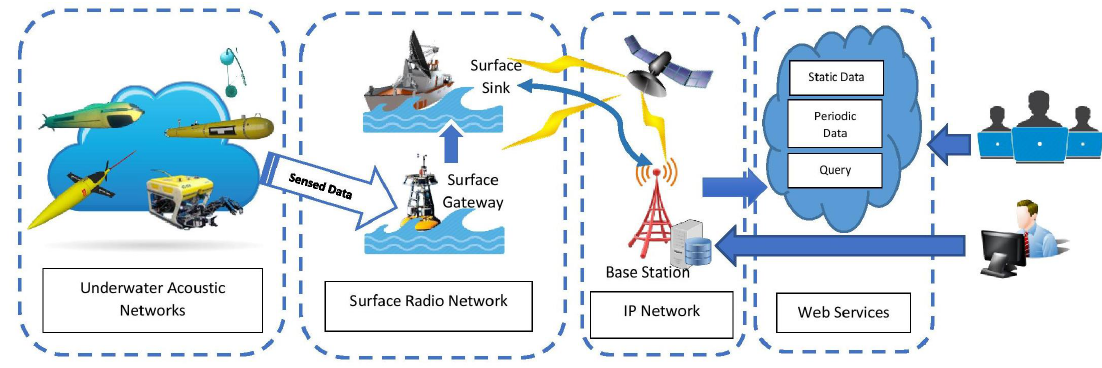
Figure 2. Overview of Underwater Wireless Sensor